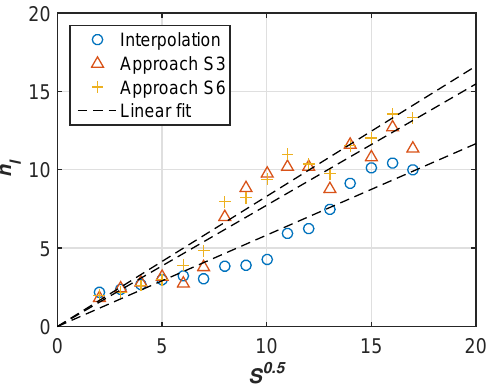
Figure 11. Relationship between crowdsensing resolution r and s crowdsensing nodes in an unit area which are generated by SLAW model. The x-axis denotes